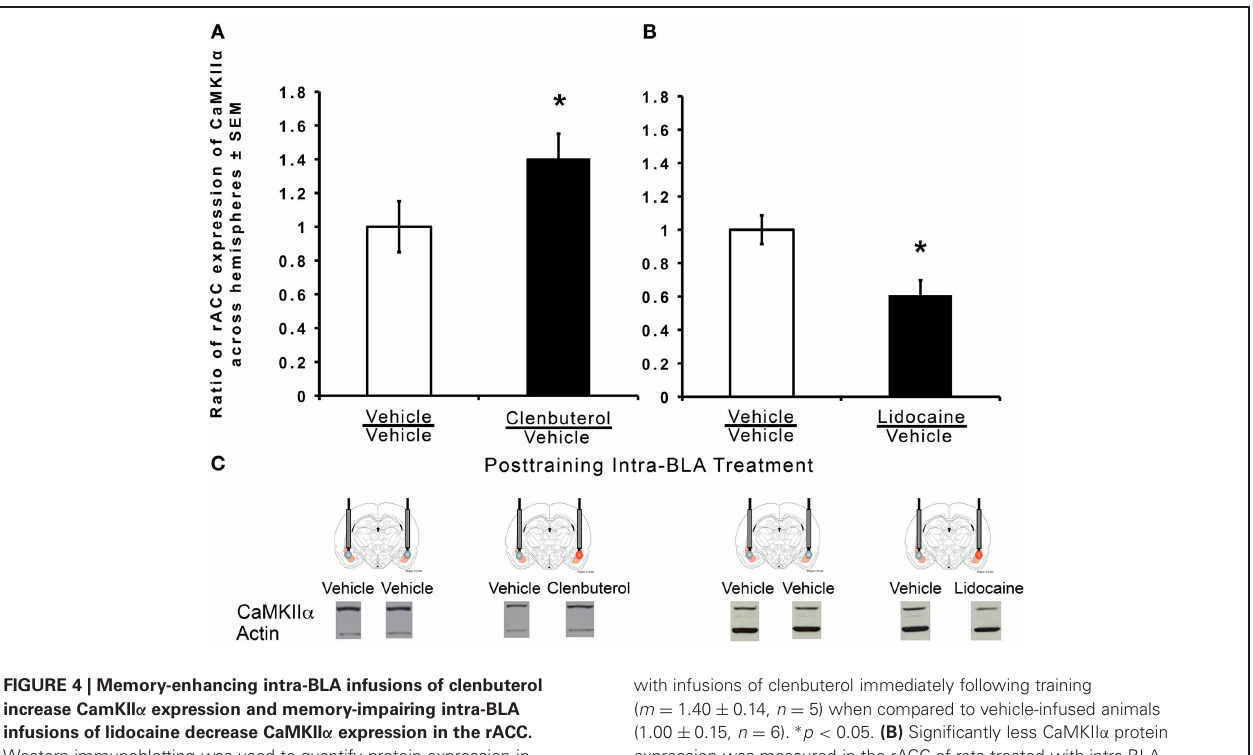
with infusions of clenbuterol immediately following training ( m = 1 . 40 ± 0 . 14, n = 5) when compared to vehicle-infused animals (1 . 00 ± 0 . 15, n = 6). ∗ p < 0 . 05. (B) Significantly less CaMKII α protein expression was measured in the rACC of rats treated with intra-BLA infusions of lidocaine immediately after training ( m = 0 . 61 ± 0 . 09, n = 7) compared to vehicle-infused animals ( m = 1 . 00 ± 0 . 09, n = 7). ∗ p < 0 .